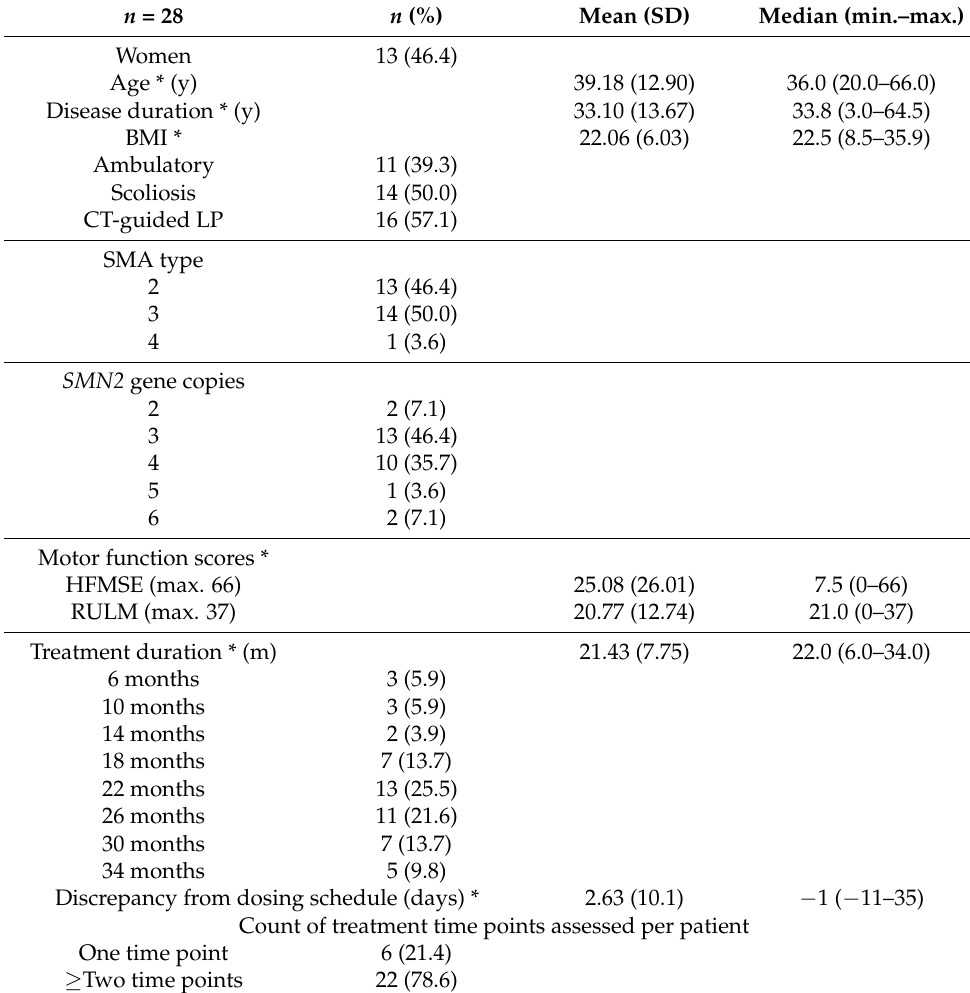
Table 1. Characteristics of enrolled adult 5q-spinal muscular atrophy (5q-SMA)